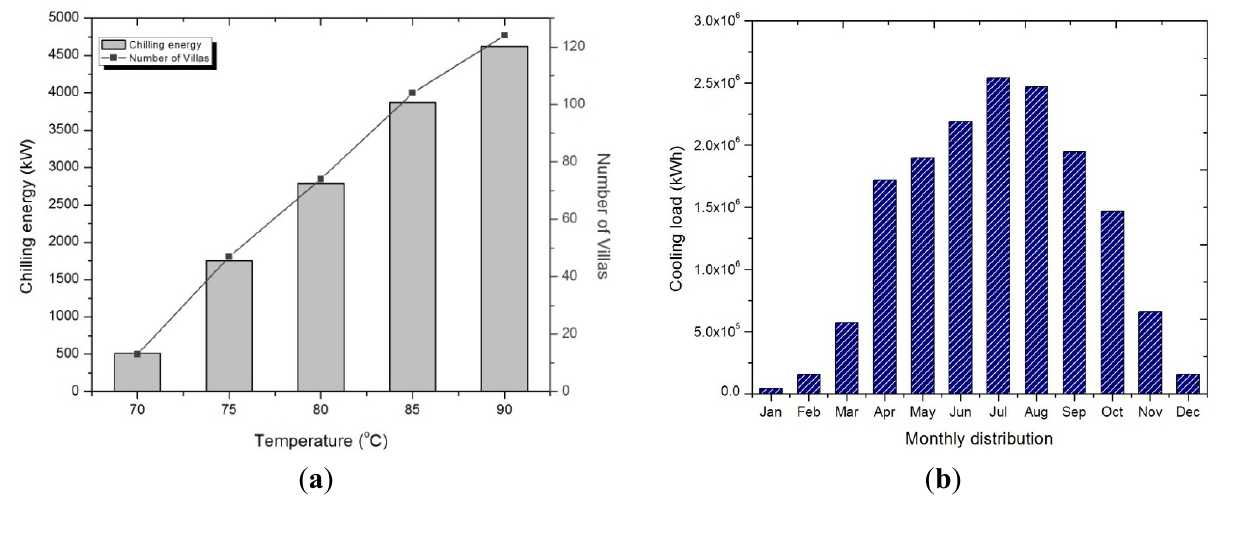
Figure 10. ( a ) Performance of absorption chiller with varying inlet hot temperature; ( b ) Month-wise cooling energy